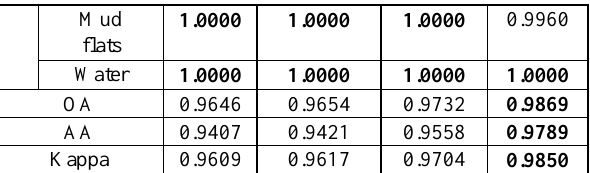
Table 4 Different spatial-spectral classification accuracy comparisons on the KSC dataset